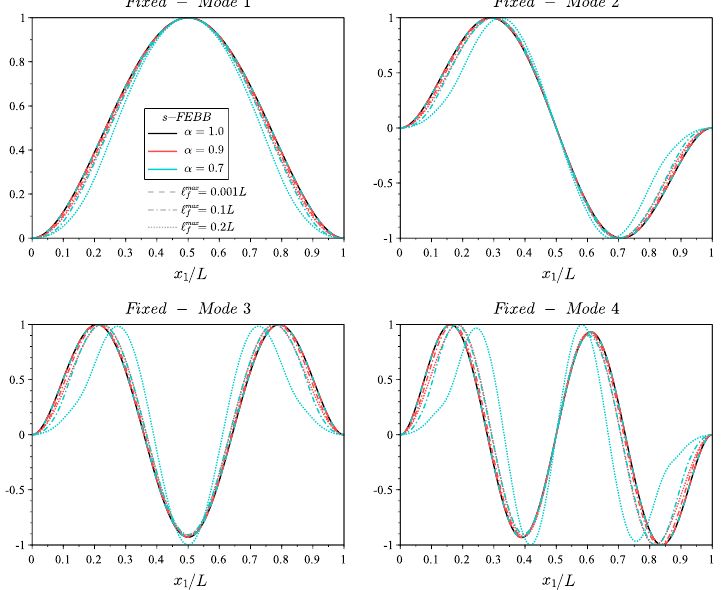
Figure 5. Shape of first four modes of fixed beam for s-FEBB model with α = [ 0.9, 0.7 ] and (cid:96) max = [ 0.001 L , 0.1 L , 0.2 L ] compared to the results of CEBB model (s-FEBB with α = f